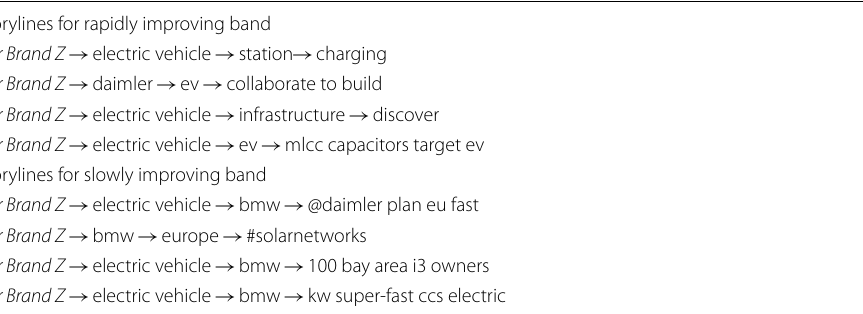
Storylines for slowly improving